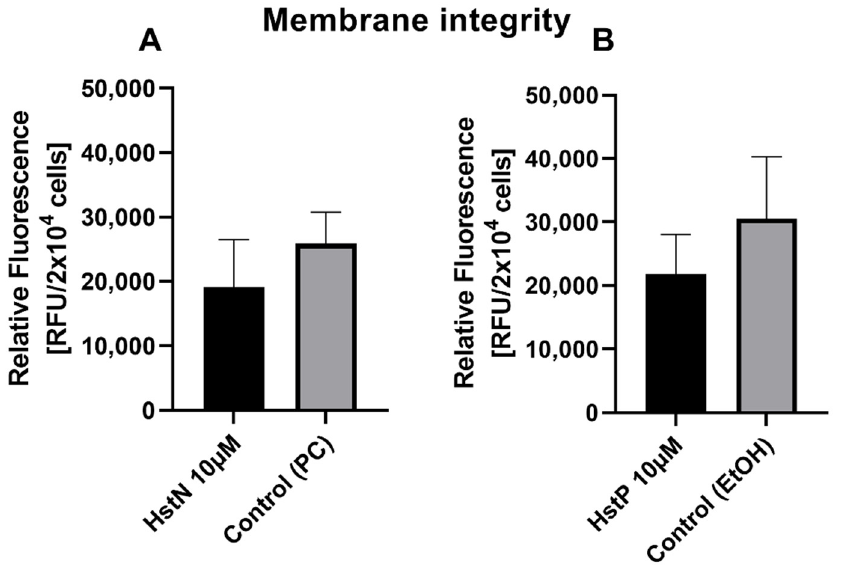
Figure 2. Effect of HstN and HstP on membrane integrity of SH-SY5Y-APP 695 cells. ( A ) Effect on membrane integrity after incubation with HstN. PC served as control. ( B ) Effect on membrane integrity after incubation with HstP. EtOH served as control. Respective mean values ± SD are shown, N = 4. Significance was determined by unpaired Student’s t-test. HstN, hesperetin nanocrystal; HstP, hesperetin in pure form; PC, PlantaCare; EtOH, ethanol .